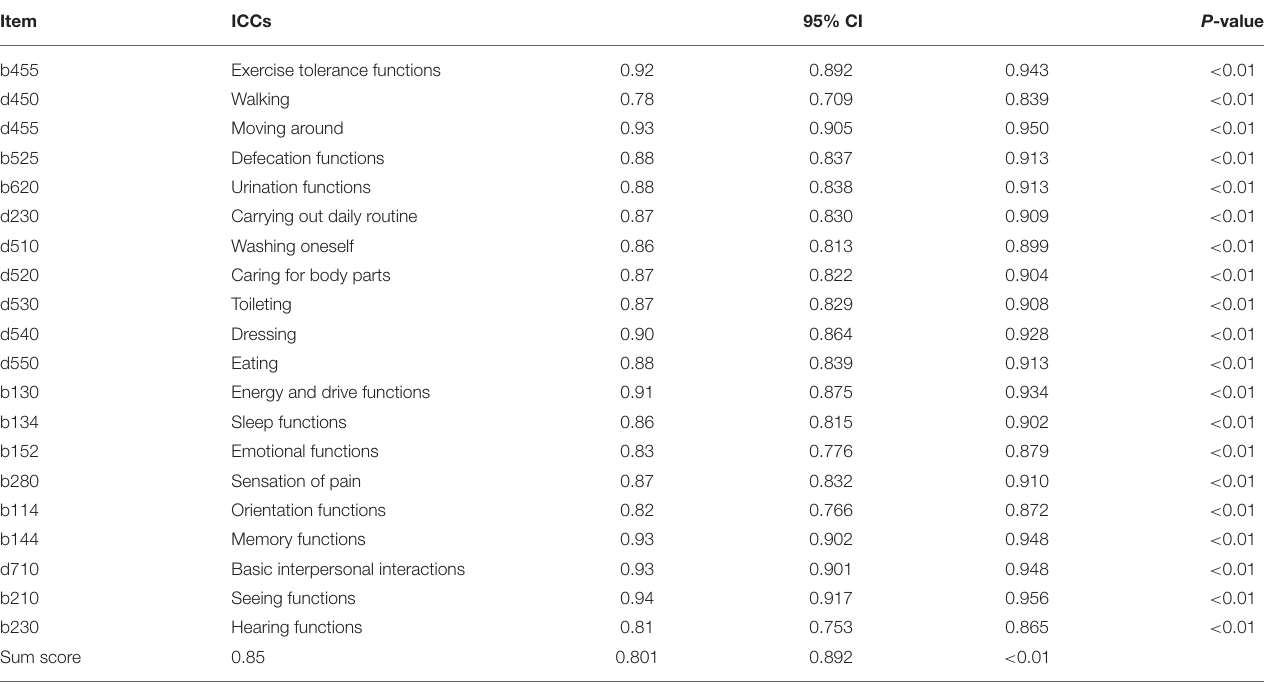
TABLE 3 | IRR of disability assessing tool based on ICF ( n =